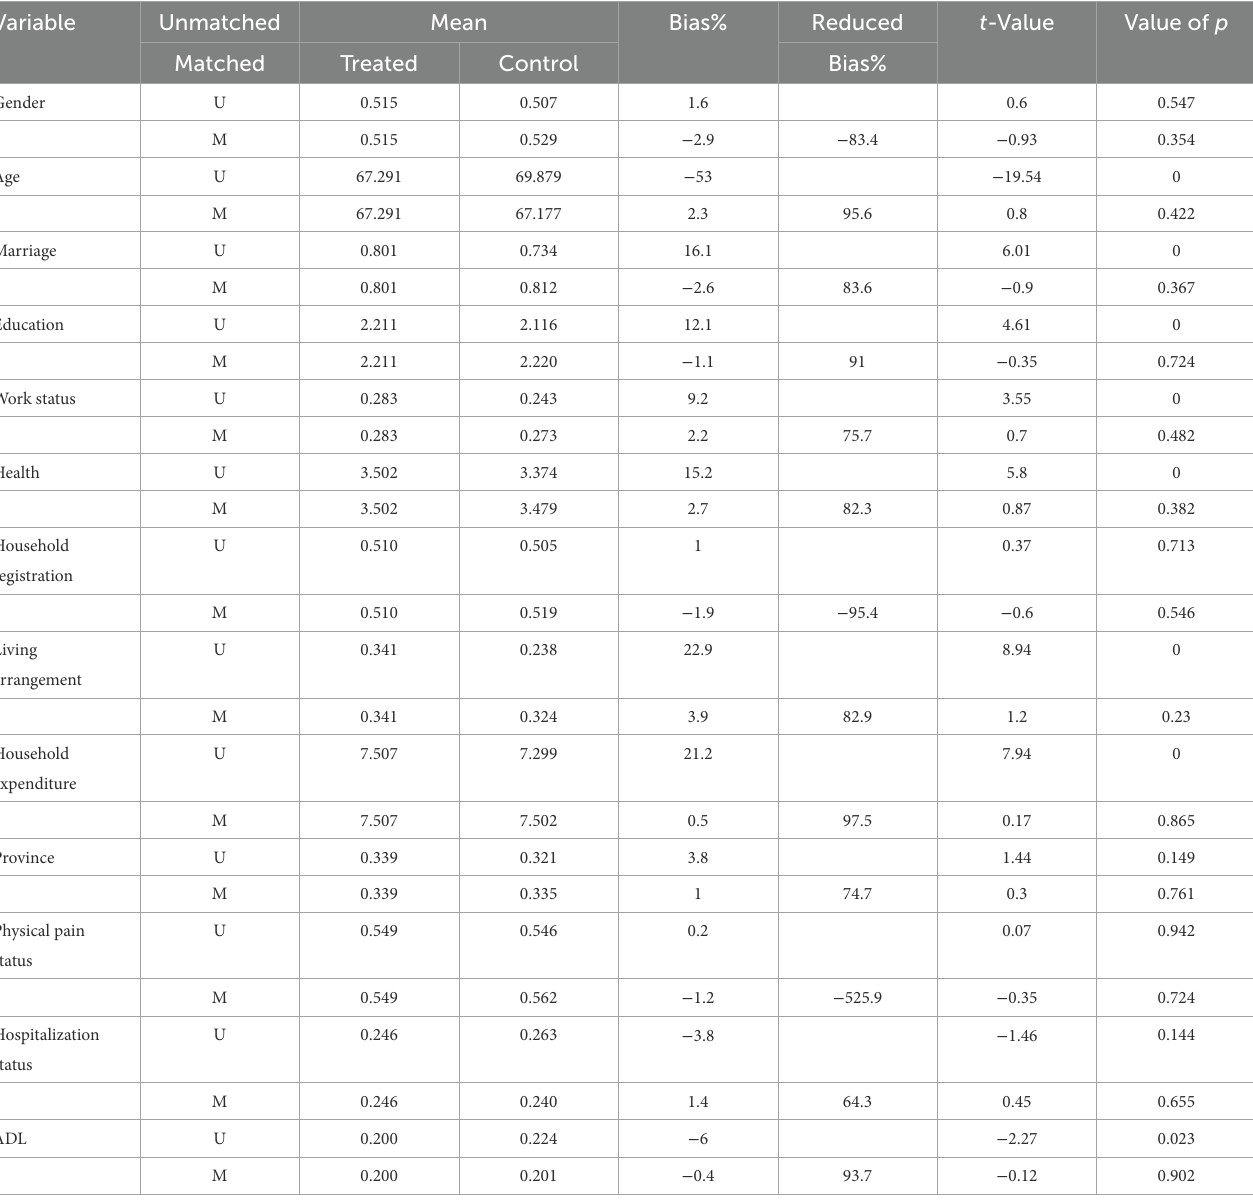
TABLE 4 Balance test. Variable Unmatched Mean Bias% Reduced t -Value Value of p Matched Treated Control Bias%